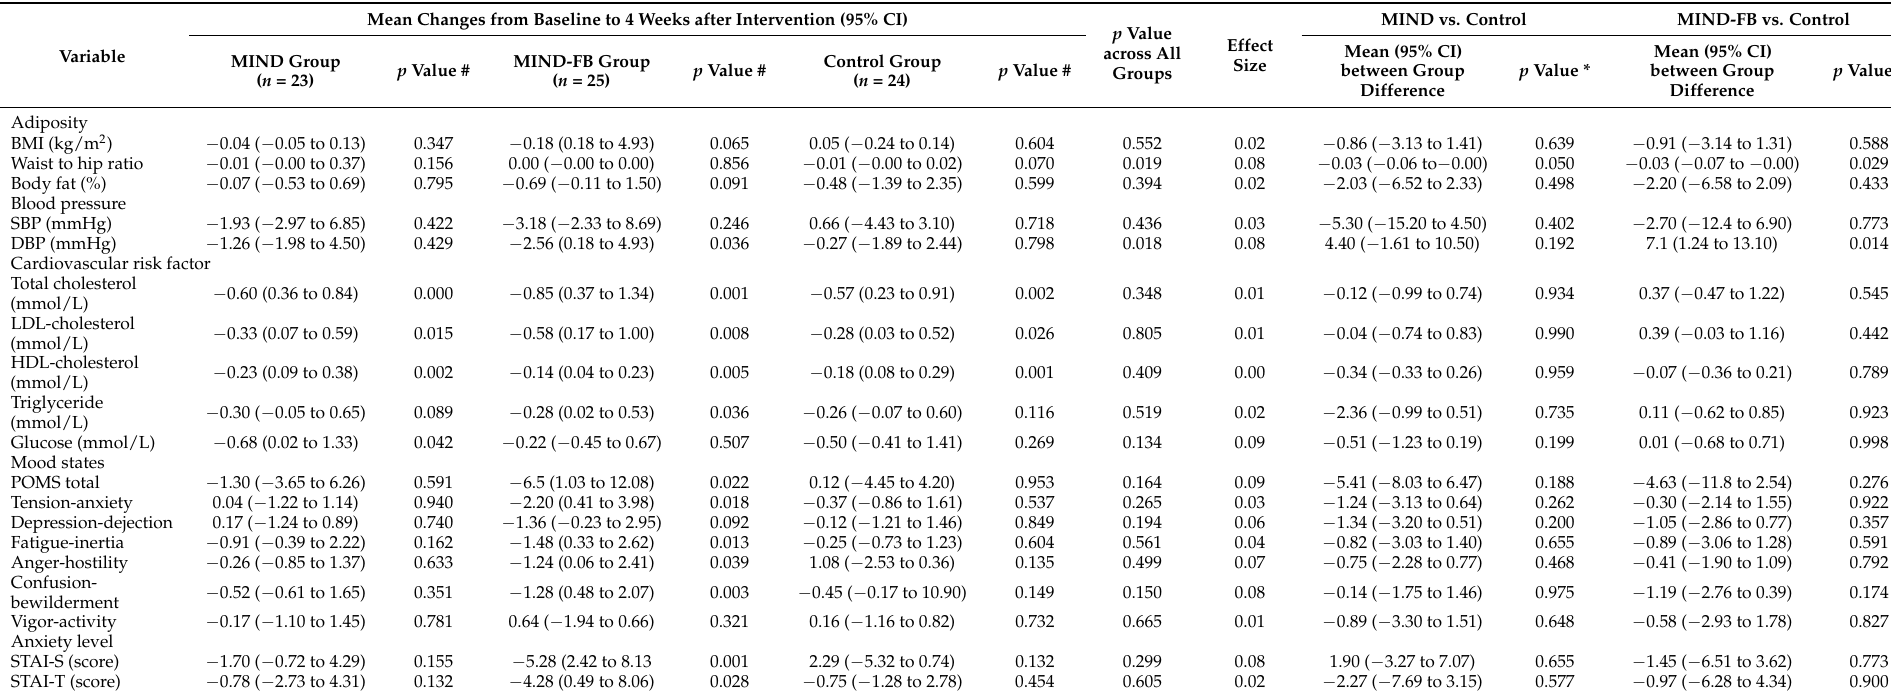
Table 4. Changes in Adiposity, Blood pressure and Cardiovascular Risk factors, Mood state, Anxiety level and MIND diet pattern (ITT analysis).